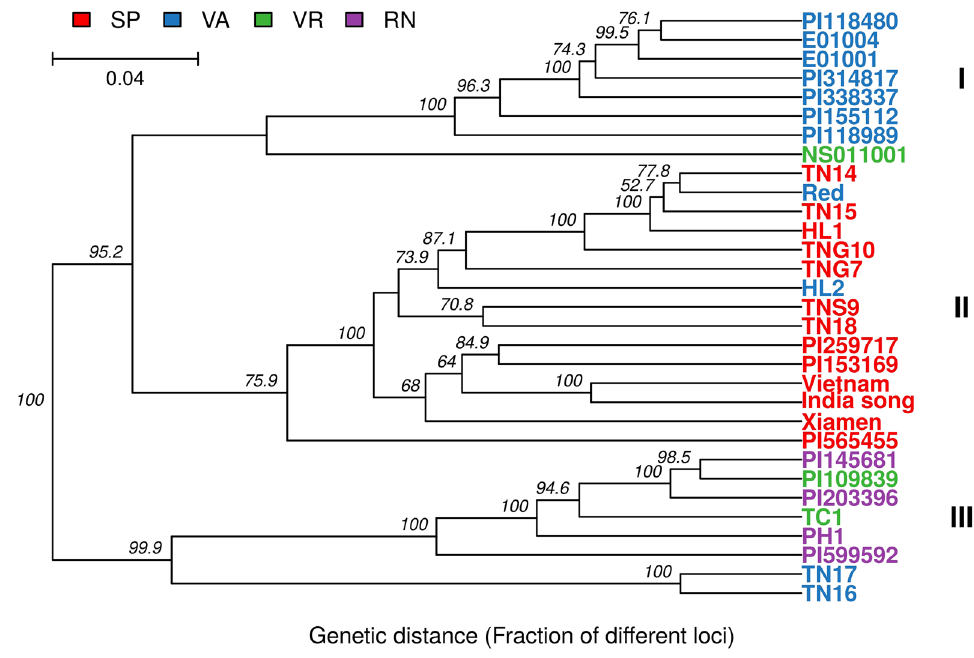
Figure 1. Dendrogram of the 31 accessions created from the unweighted pair group method with arithmetic mean (UPGMA). This dendrogram was based on the pairwise genetic distance with 1000 replicates using 3474 single nucleotide polymorphisms (SNPs). The branch length represents genetic distance, and the scale is on the top left of this figure. The numbers on the branches are bootstrap percentages. The legend shows the color of four market types, Spanish (SP), Valencia (VA), Virginia (VR), Runner (RN), and three clades clustered in this plot were named as I, II and